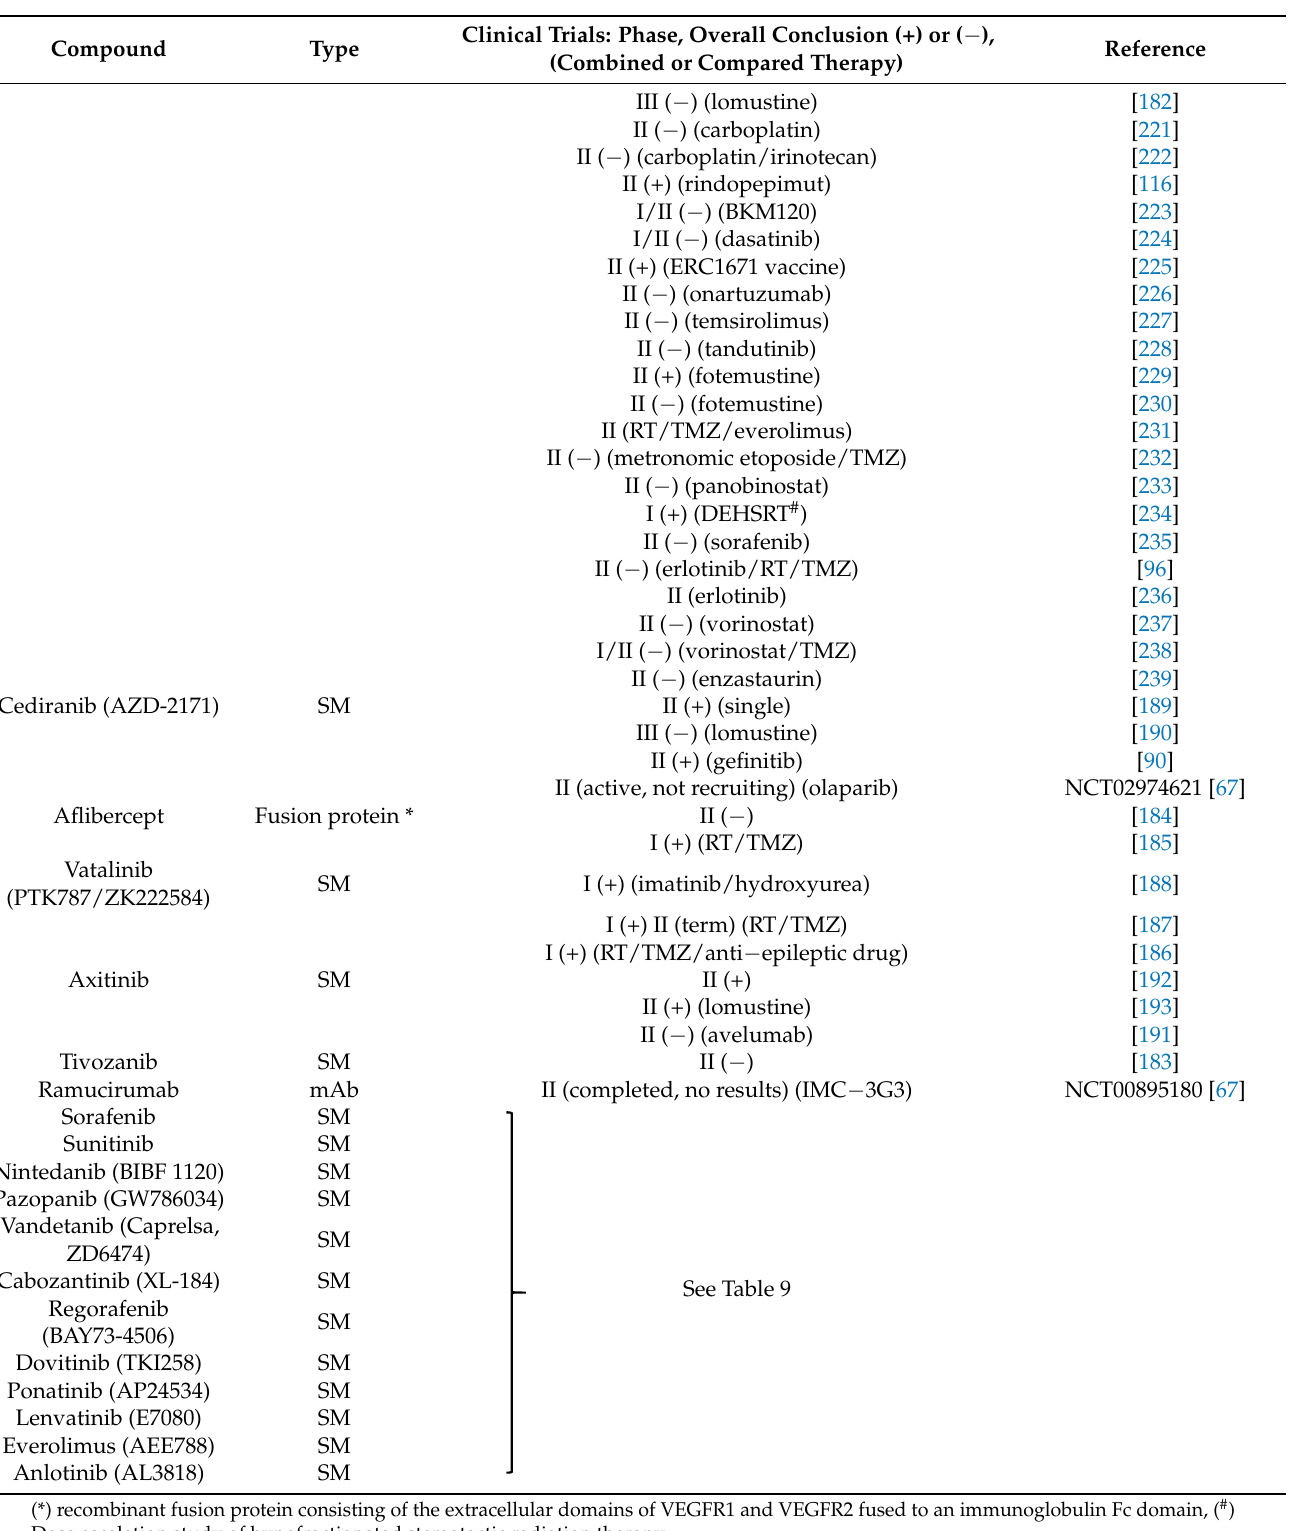
(*) recombinant fusion protein consisting of the extracellular domains of VEGFR1 and VEGFR2 fused to an immunoglobu- lin Fc domain, ( # ) Dose escalation study of hypofractionated stereotactic radiation